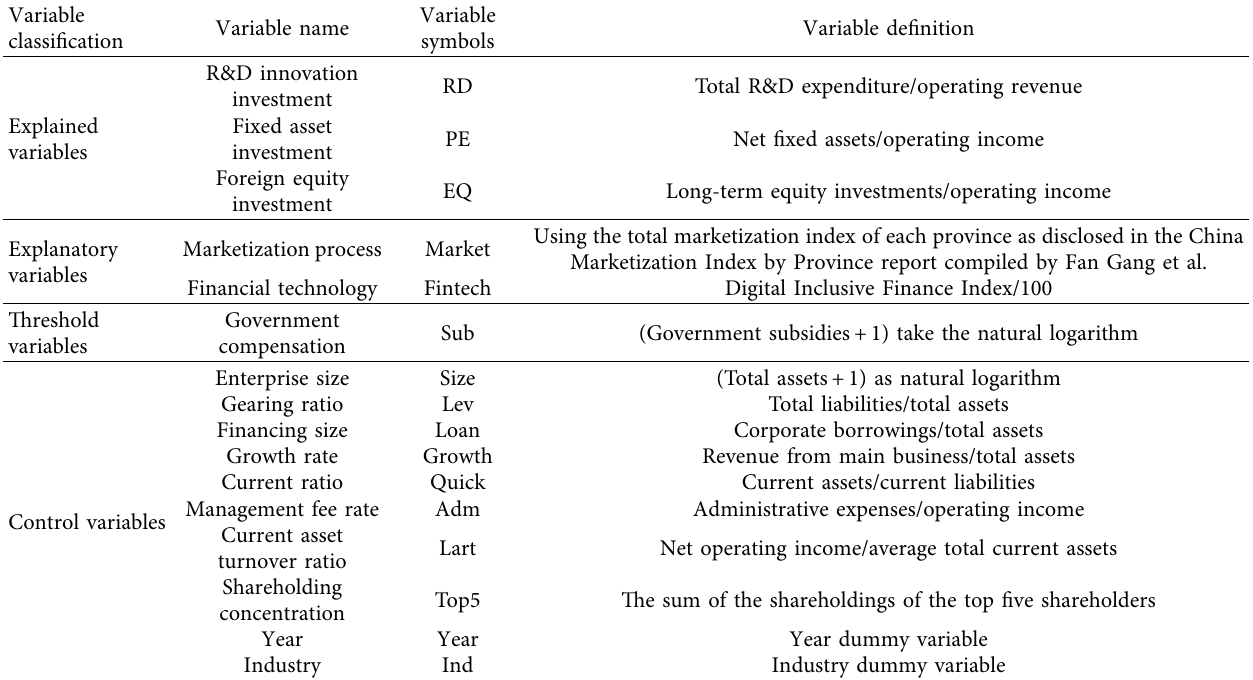
Table 1: Definition of main